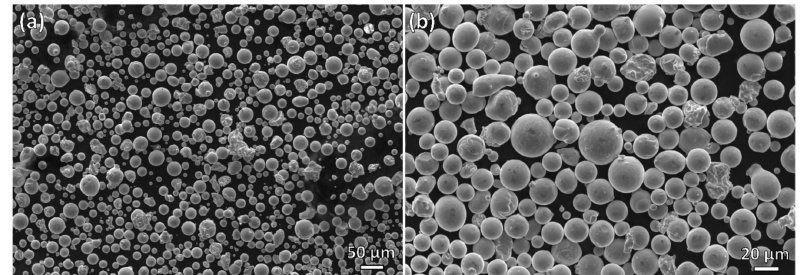
Figure A2. Secondary electron SEM micrographs of the virgin powders of the MAD542 superalloy for laser powder bed fusion. ( a ) at low magnification with an overall view and ( b ) at high magnification with a detailed view.